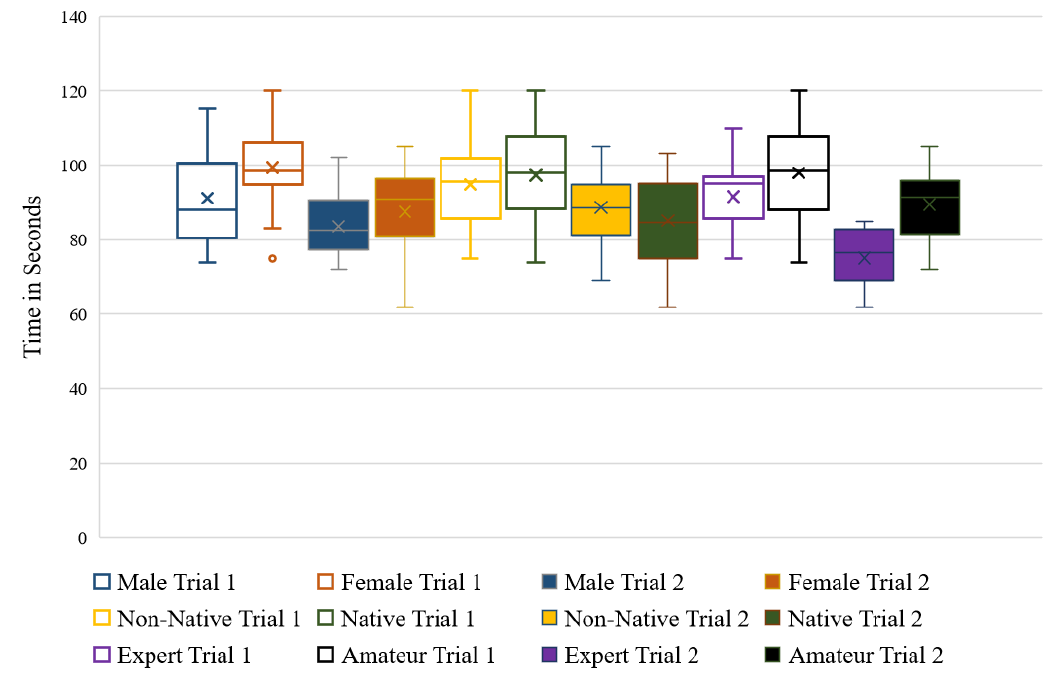
Figure 11. Task completion time for HMT identified